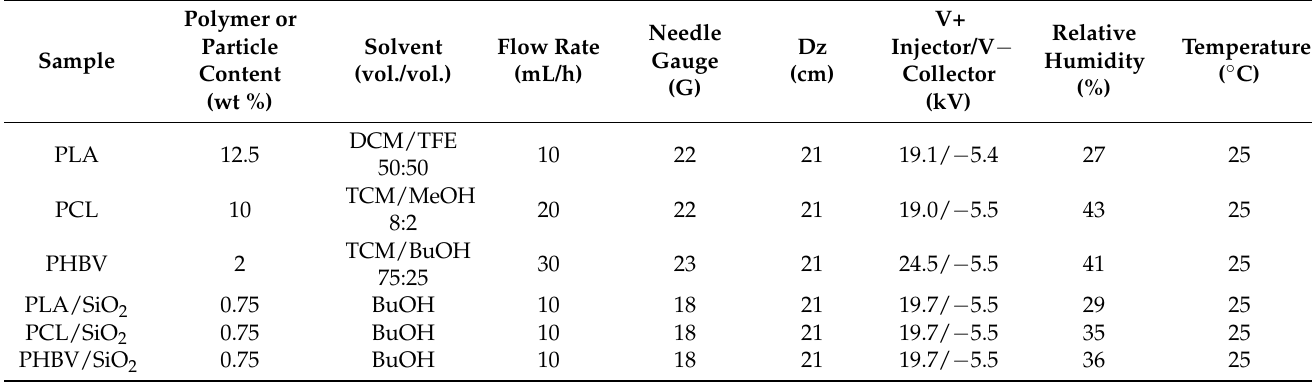
Table 1. Electrospinning parameters for polylactide (PLA), poly( ε -caprolactone) (PCL), and poly(3-hy-droxybutyrate-co-3- hydroxy-valerate) (PHBV) and the electrospraying of the hydrophobic silica particles (SiO 2 ). The substrate was, in all cases, cellulose paper. Dz: Distance needle to collector.